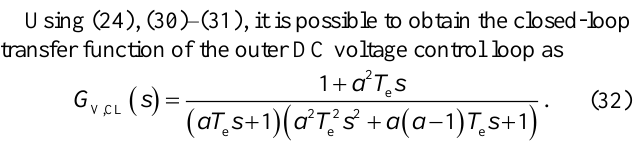
The open-loop Bode plots and step responses of the outer DC voltage control loop for different values of parameter ‘ a ’ are shown in Figs. 9–10,